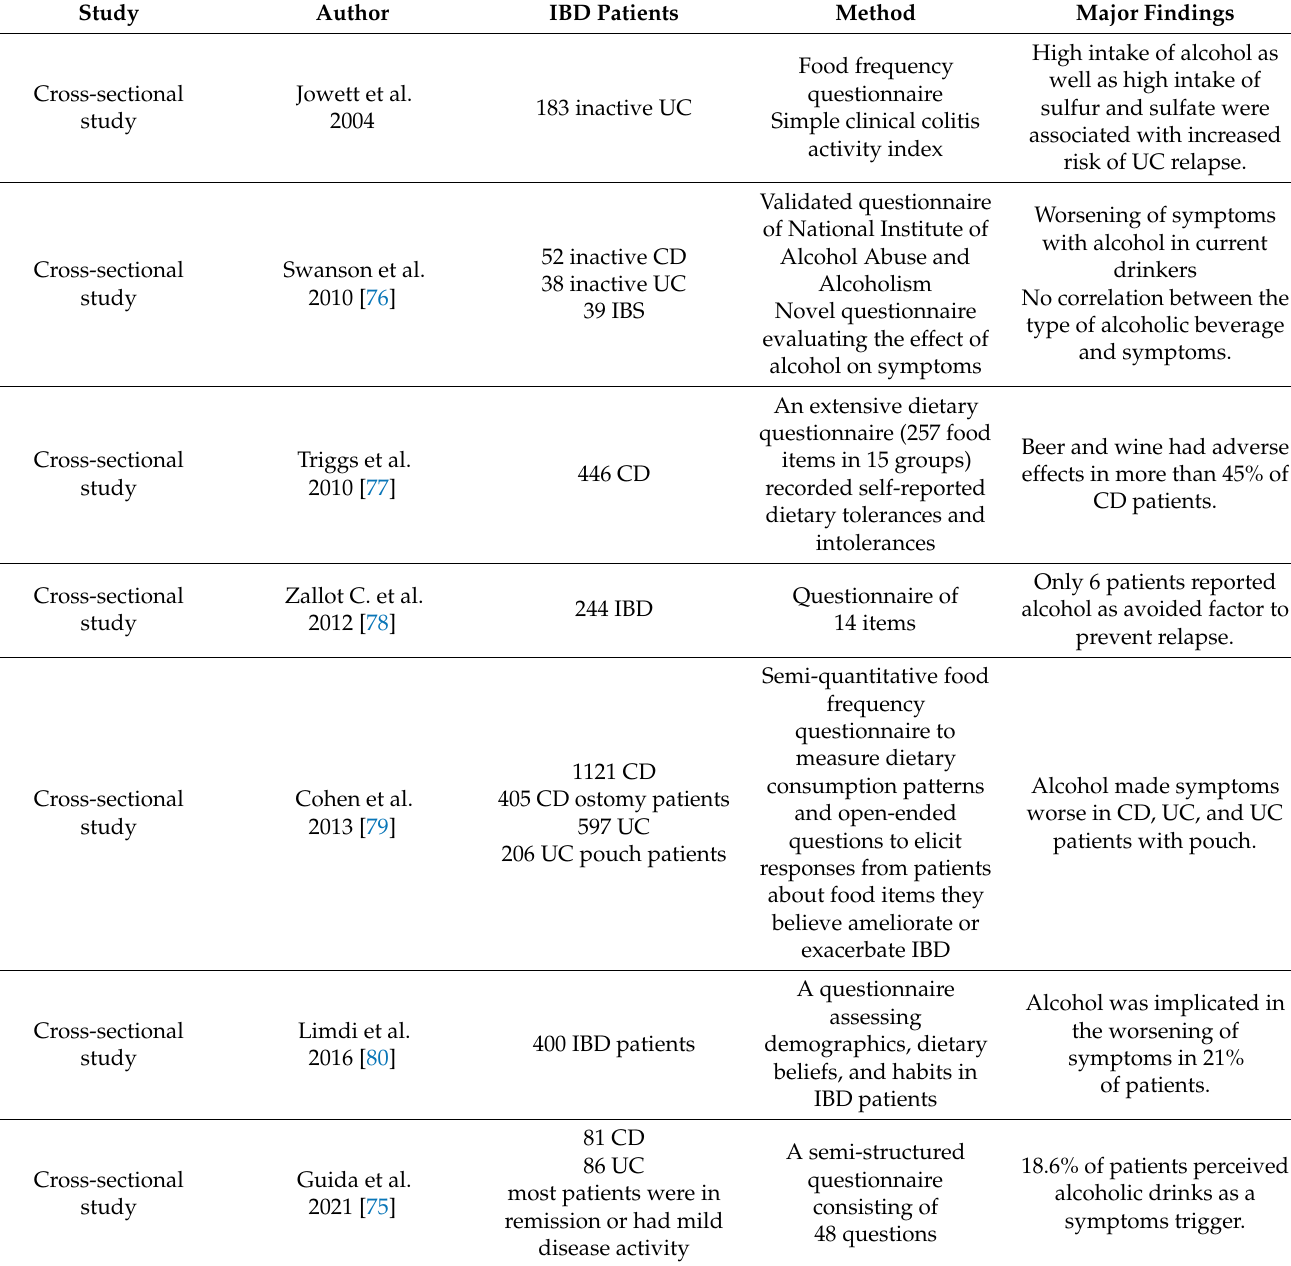
Table 3. Impact of alcohol on inflammatory bowel disease